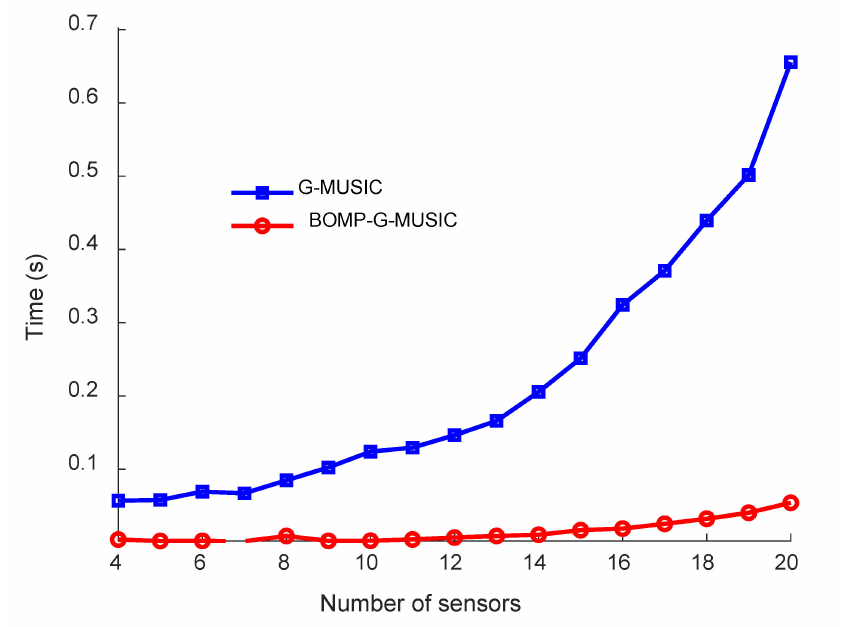
Figure 9. Comparison results of operation time of preprocessing and non‑preprocessing